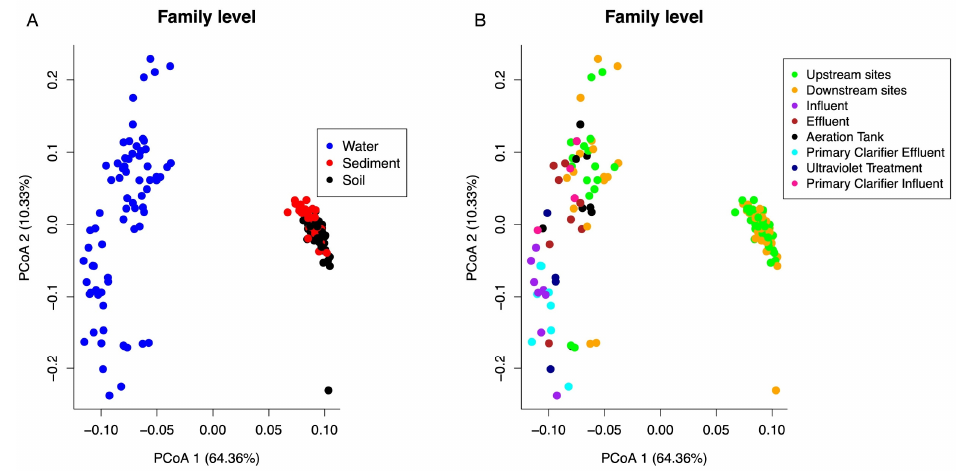
Figure 3. Principal coordinate plot of urban stream communities including wastewater treatment plants showing di ff erences between sample types ( A ) and geographical location in the river system and wastewater treatment plant ( B ). Numbers in parentheses are the percent variance explained by each axis.